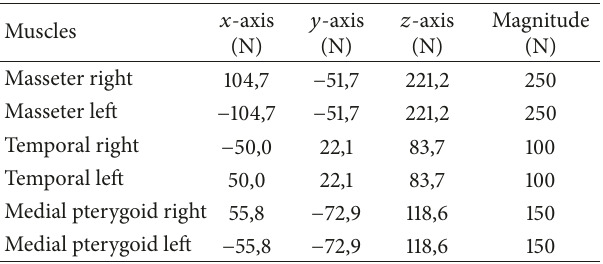
Table 1: Direction in space of the force vectors representing each muscle of mastication and its magnitude. Source: adapted from Bertol [20].